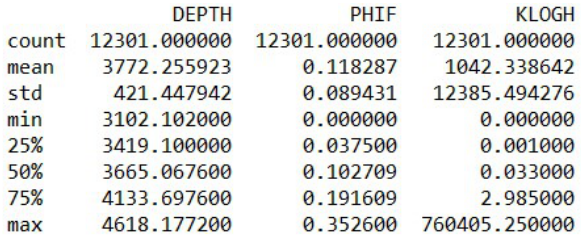
Table 1. The statistical description of porosity (PHIF) and permeability (KLOGH). Number of points, mean, standard deviation, minimum and quartile values are shown. (Modified